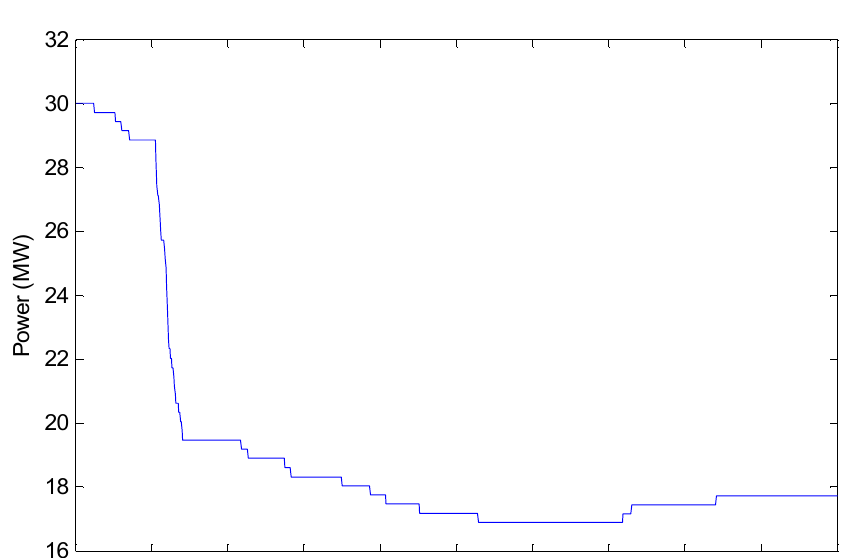
Figure 12. Frequency dynamics.